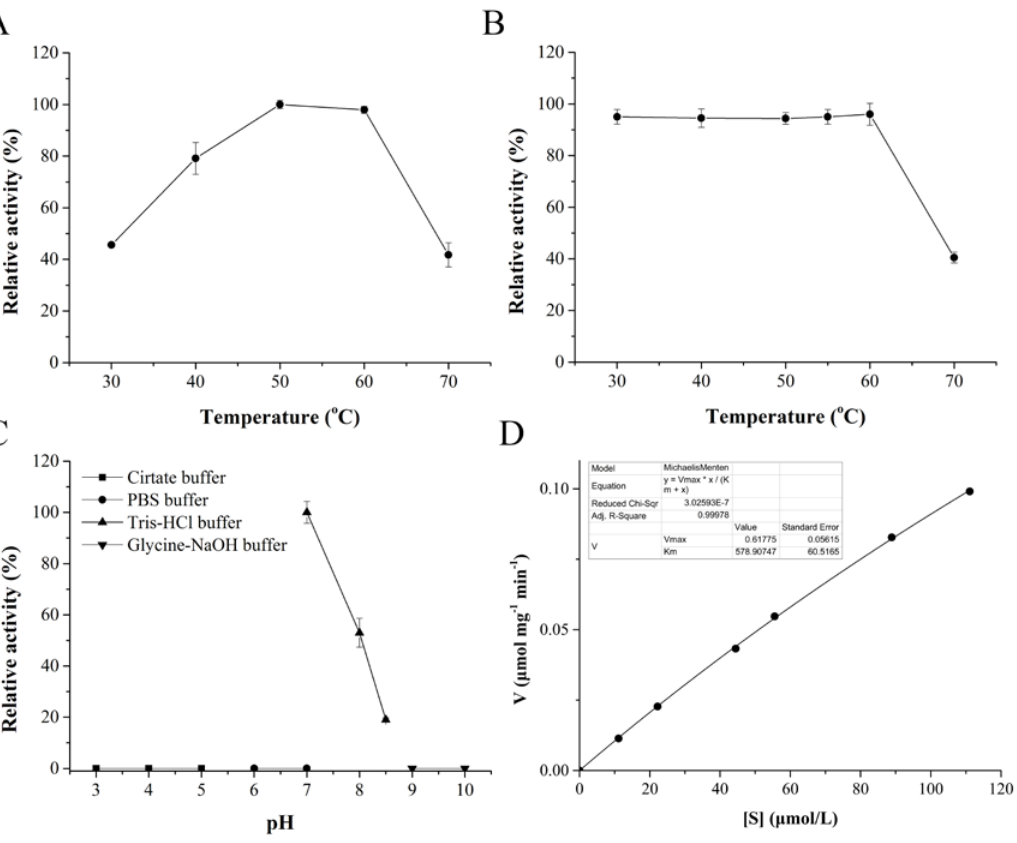
Figure 3. Biochemical properties of Co DPP III. ( A ) Optimal temperature, ( B ) thermo stability, ( C ) optimal pH, and ( D ) Michaelis–Menten plot.